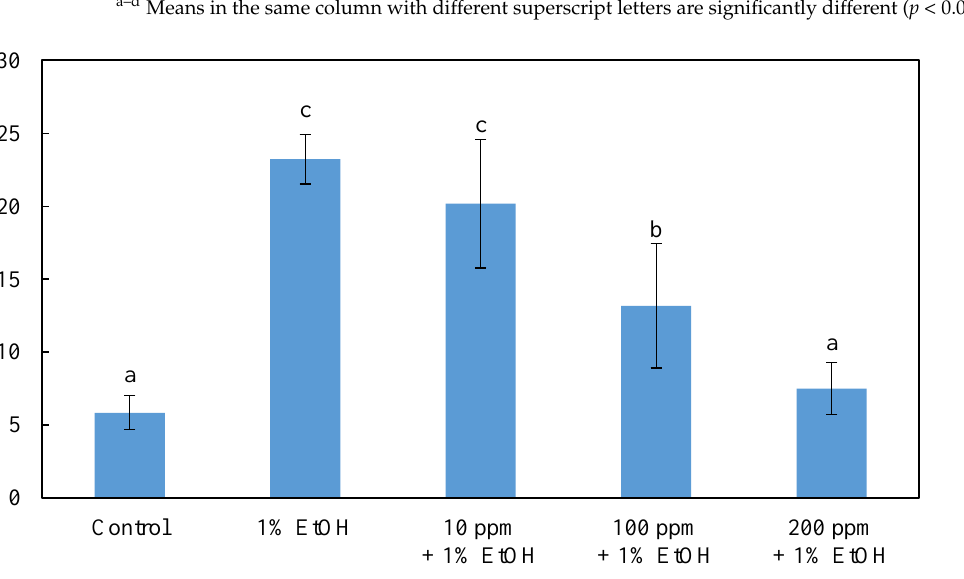
Figure 3. Effect of pretreatment with different concentrations of an ethanol extract of the Hericium erinaceus solid-state fermented wheat product (effect of HEEE on the brain cells of zebrafish embryo). The bar graphs represent the mean number of acridine orange-labeled cells, mean ± S.D.; n = 8 embryos. a–c The mean cell death values with different letters are significantly different ( p < 0.05).